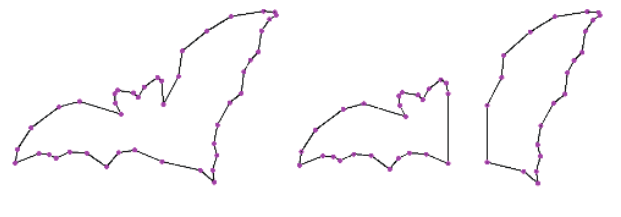
Figure 10. Incomplete contour-approximation